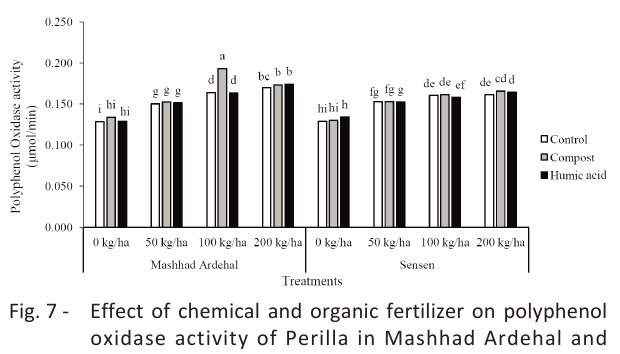
Fig. 7 - Effect of chemical and organic fertilizer on polyphenol oxidase activity of Perilla in Mashhad Ardehal and Sensen regions. Different letters in each column denote a significant difference at p≤0.05 (LSD